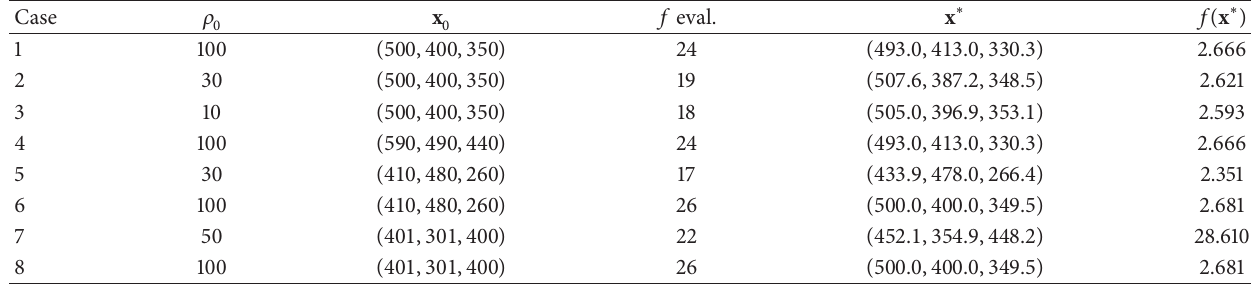
Table 2: Influence of the starting point and the initial trust region size on the rate of convergence and the local minima. 𝑛 = 10 −3 × 𝑥 ∗ 3 .